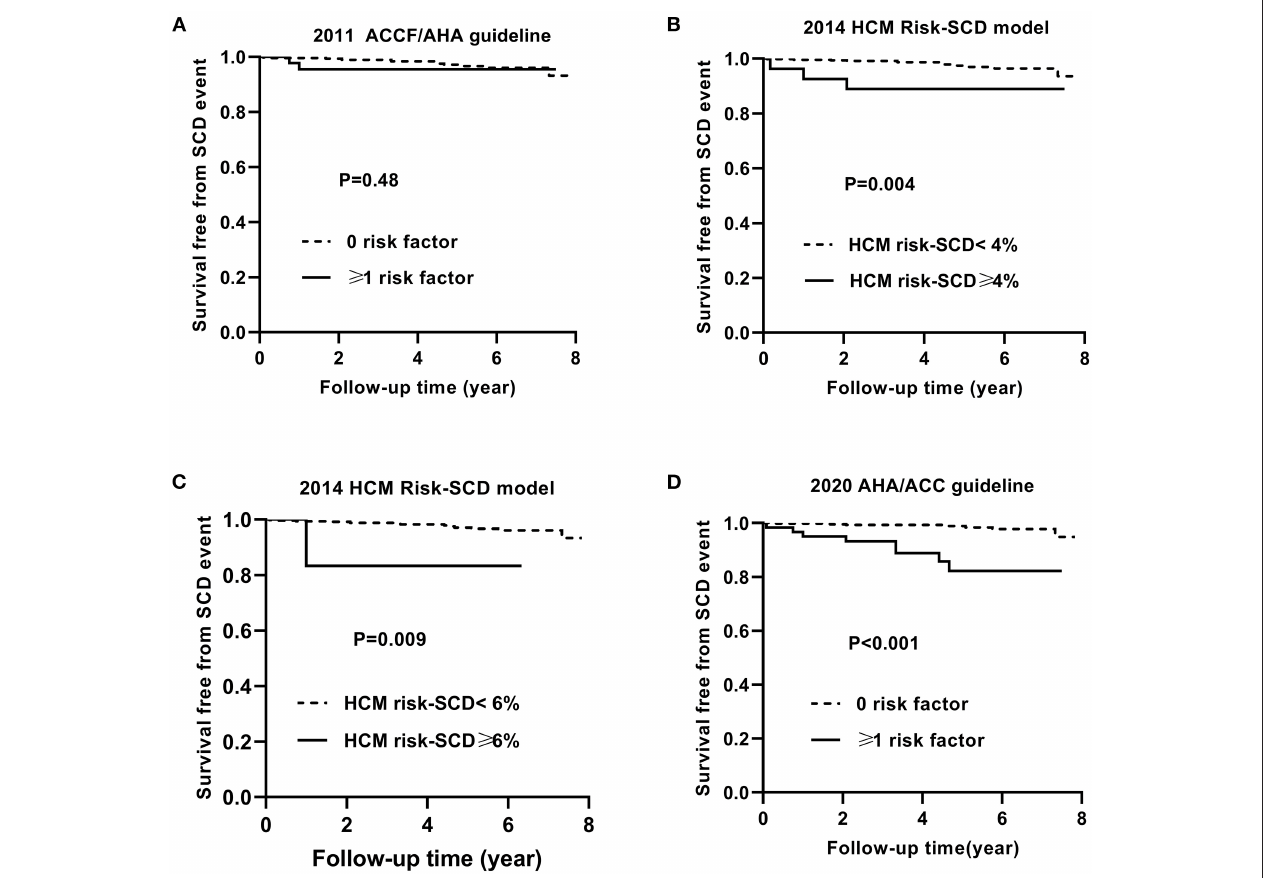
FIGURE 3 | Kaplan–Meier curves for survival free from the sudden cardiac death (SCD) event by risk stratifications based on the 2011 ACCF/AHA (A) , the 2014 ESC guideline with a cut-off level of 4% (B) and 6% (C) , and the 2020 AHA/ACC guidelines (D) .